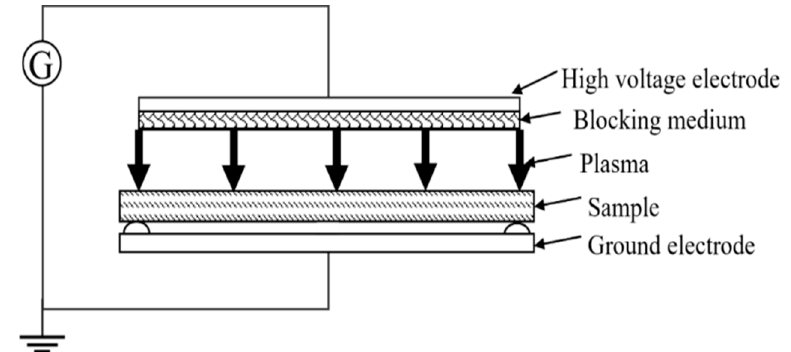
Figure 2. Dielectric barrier discharge plasma schematic diagram.